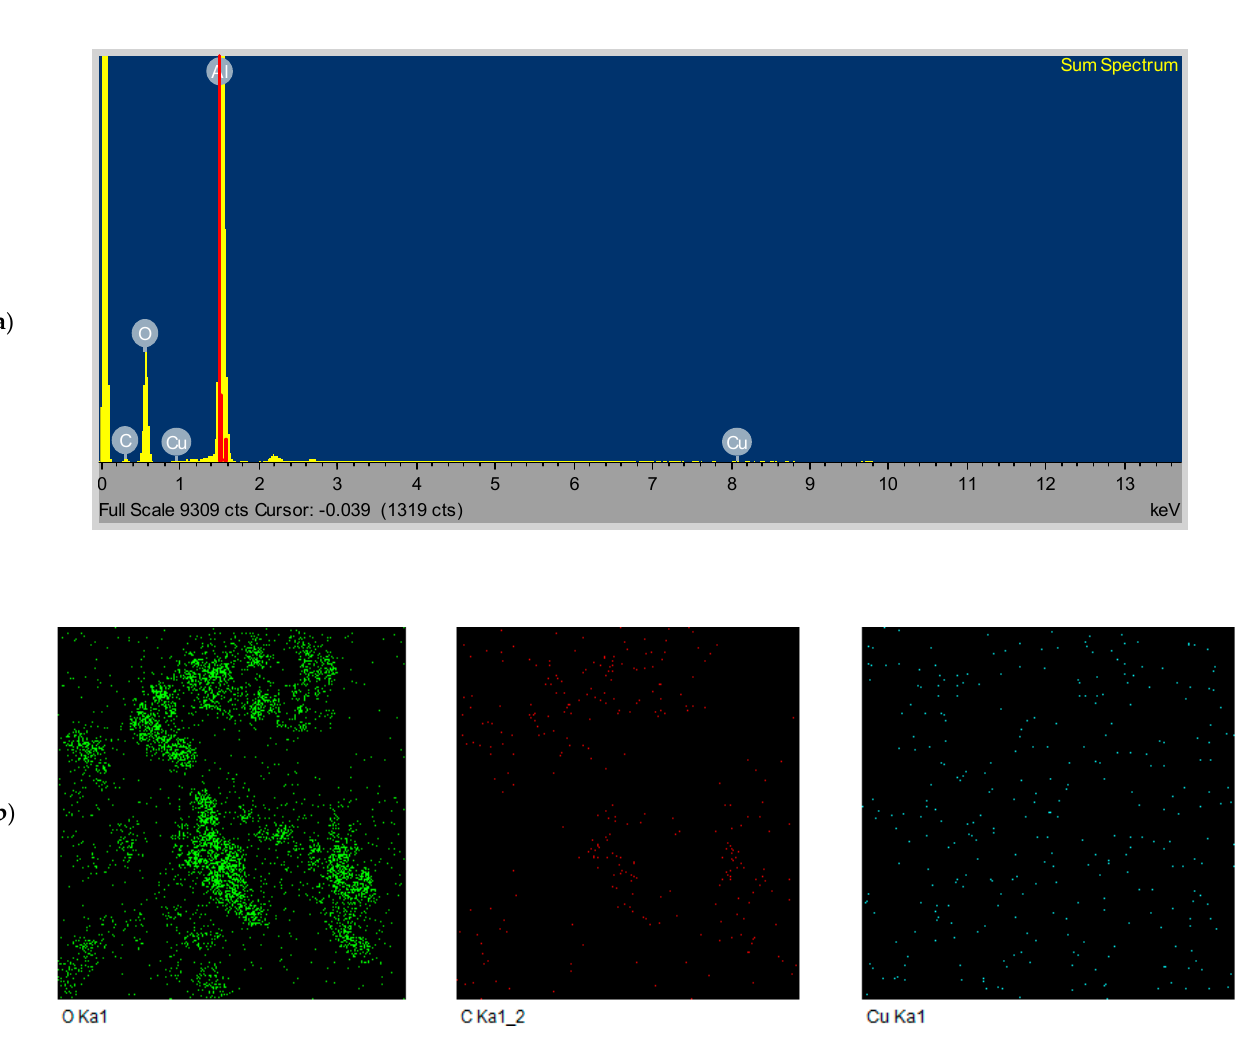
Figure 7. ( a ) EDS spectrum and ( b ) elemental mapping of CHT − CuO nanocomposite.